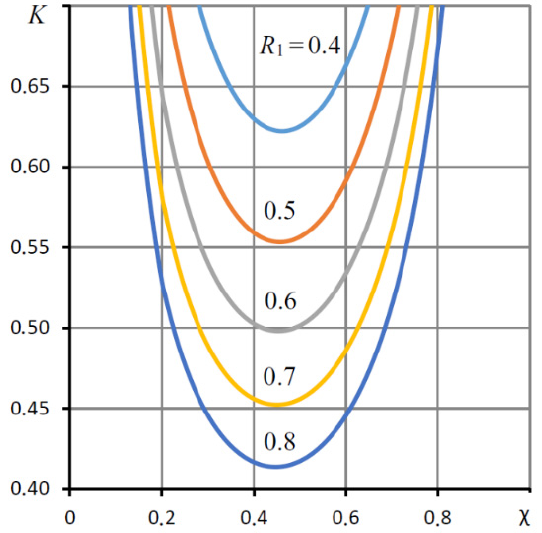
Figure 2. Graph of the dependence of compliance K on the coefficient χ for P s = 4 and different R 1 .